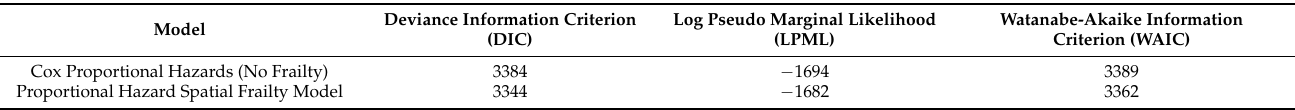
Table 1. Model Comparison Results Table 1. The model comparison